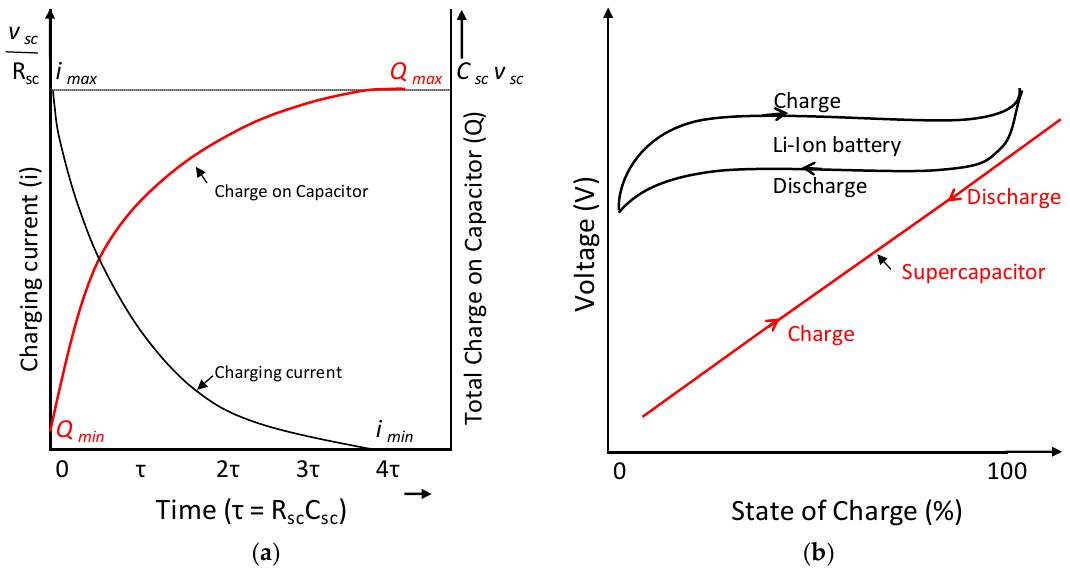
Figure 3. ( a ) Behavior of supercapacitor charge and its current with time; and ( b ) charge/discharge curves of supercapacitor and Li-ion battery.